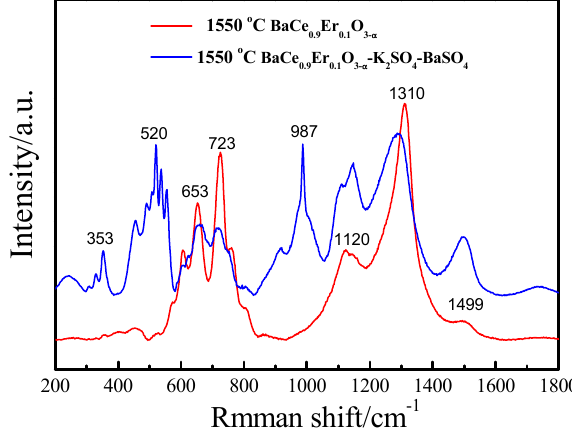
Figure 4. Raman spectra of BaCe 0.9 Er 0.1 O 3 −α (1550 °C) and BaCe 0.9 Er 0.1 O 3 −α –K 2 SO 4 –BaSO 4 .